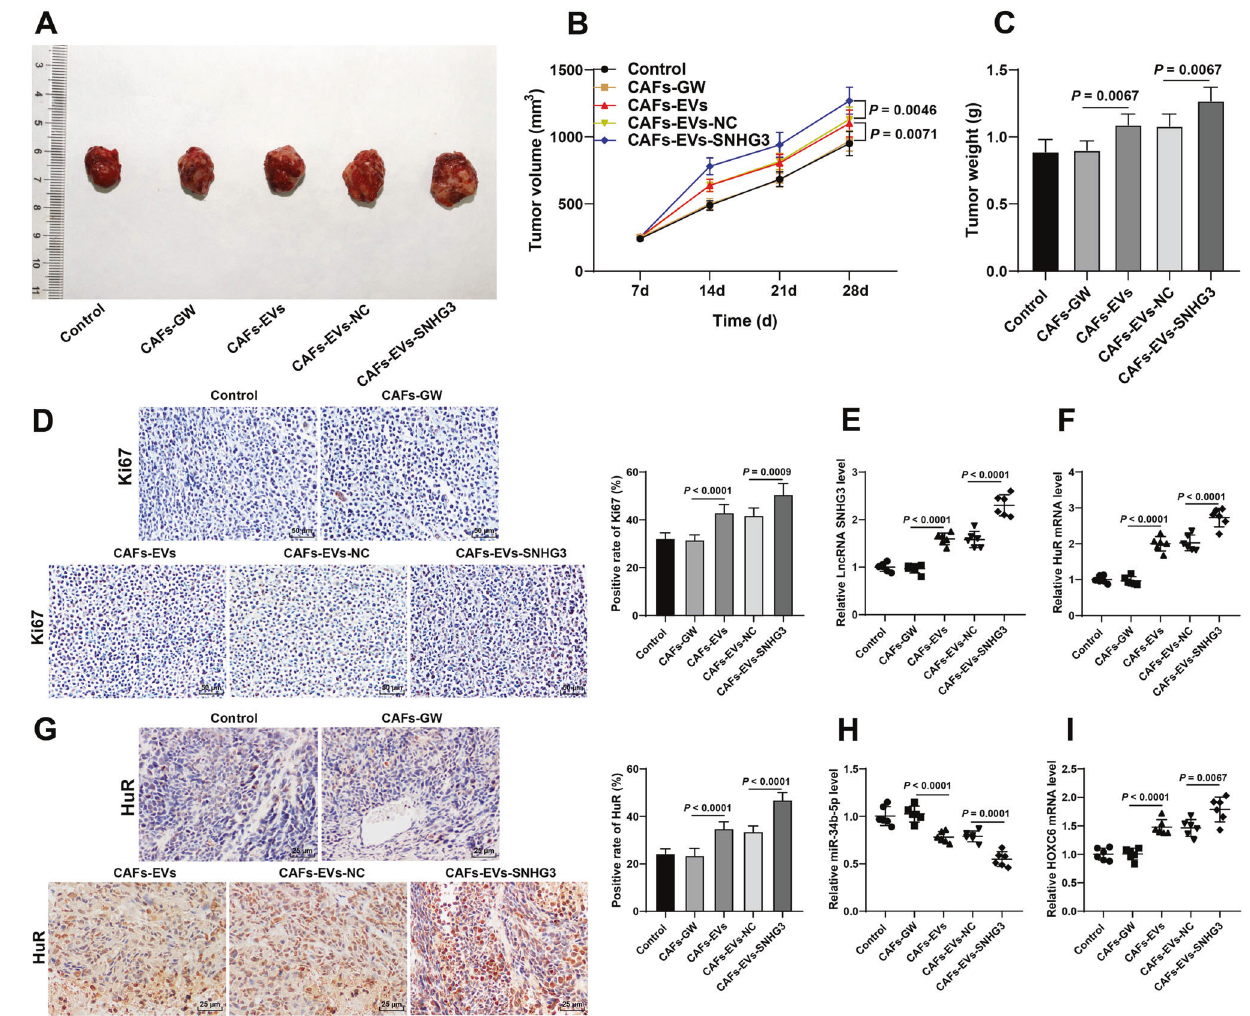
Fig. 8 CAFs-EVs carrying SNHG3 enhanced CRC cell proliferation in vivo via the miR-34b-5p/HuR/HOXC6 axis. The murine xenograft model was established by CAFs-GW- or CAFs-EVs-treated HCT116 cells. A Representative images of xenograft tumor. B Tumor volume. C The tumor weight on the 28th day after euthanasia in nude mice. D The positive rate of ki67 in tumor tissues was detected using immunohistochemistry. E , F SNHG3 and HuR expressions in tumor tissues were determined using RT-qPCR. G: The positive rate of HuR in tumor tissues was detected using immunohistochemistry. H, I miR-34b-5p and HOXC6 expressions in tumor tissues were determined using RT-qPCR. N = 6 or N = 12. Data in B / C / D / G are presented as mean ± standard deviation. Data in C – I were analyzed using one-way ANOVA, and data in B were analyzed using two-way ANOVA, followed by Tukey ’ s multiple comparisons